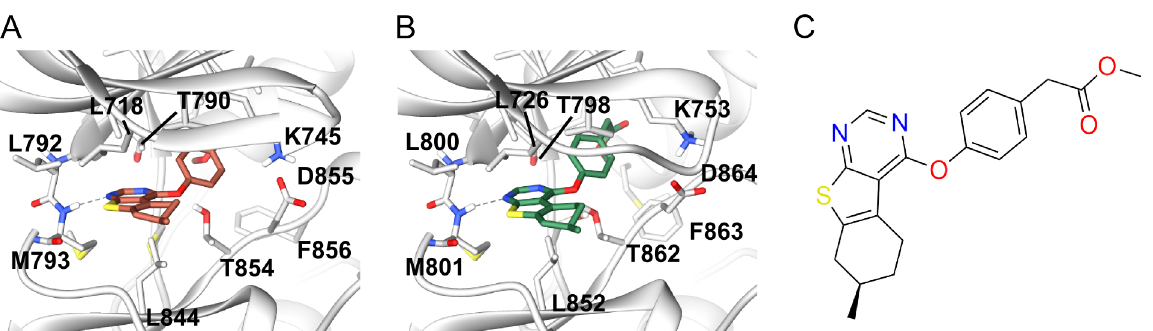
Figure 1. Docking poses of the R-enantiomer of compound DS39984 bound to ( A ) EGFR (PDB 3POZ, DFG-in) and ( B ) ErbB2 (PDB 3PP0, DFG-in); and ( C ) 2D representation of DS39984. The protein structure is shown as cartoon, colored in grey, the compound as sticks. Interacting binding site residues are represented as sticks and labeled. Hydrogen bonds between protein and ligand are indicated by dark gray dashed